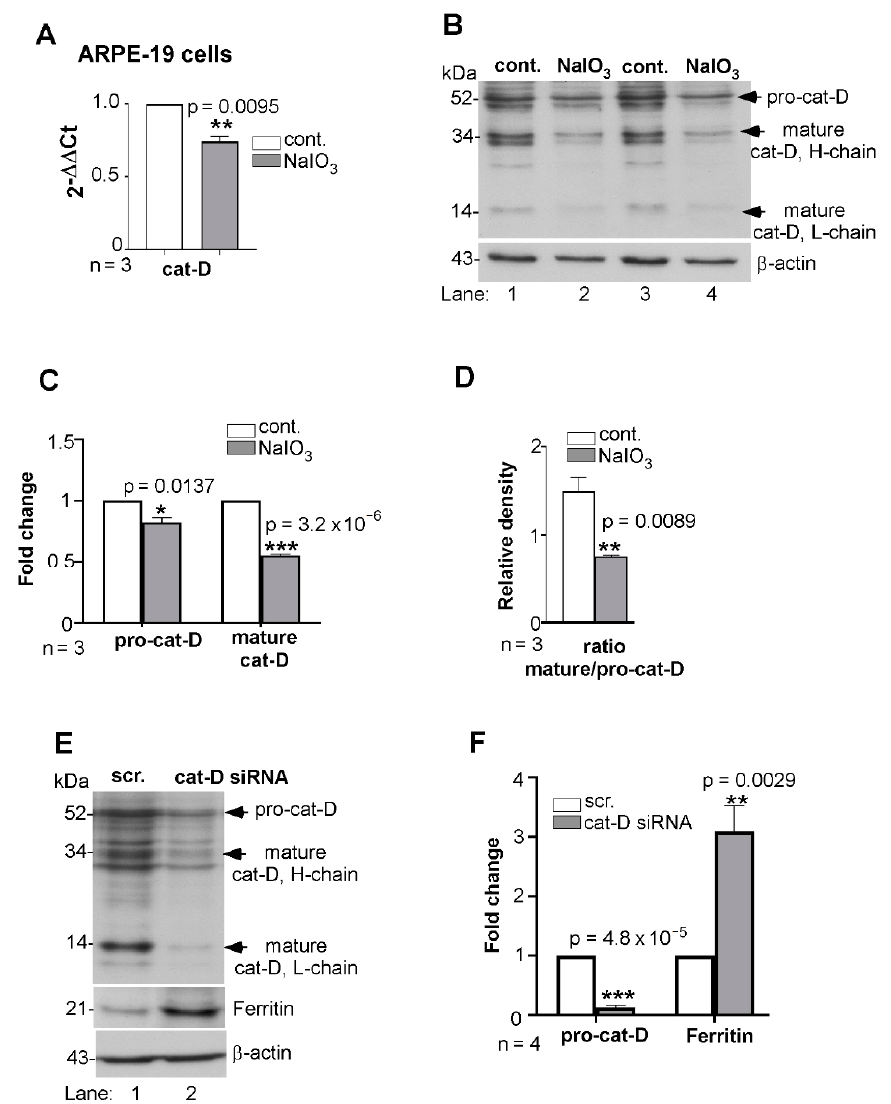
were transfected with cat-D-specific siRNA and the lysates were let to immunoreact with ferritin. Successful downregulation of cat-D resulted in increased accumulation of ferritin siRNA-treated controls (Figure 4E, lanes 2 vs. 1; Figure 4F), suggesting ferritin to be one of relative to scrambled siRNA-treated controls (Figure 4E, lanes 2 vs. 1; Figure 4F), suggest- the substrates processed by cat-D in these cells. ing ferritin to be one of the substrates processed by cat-D in these cells.